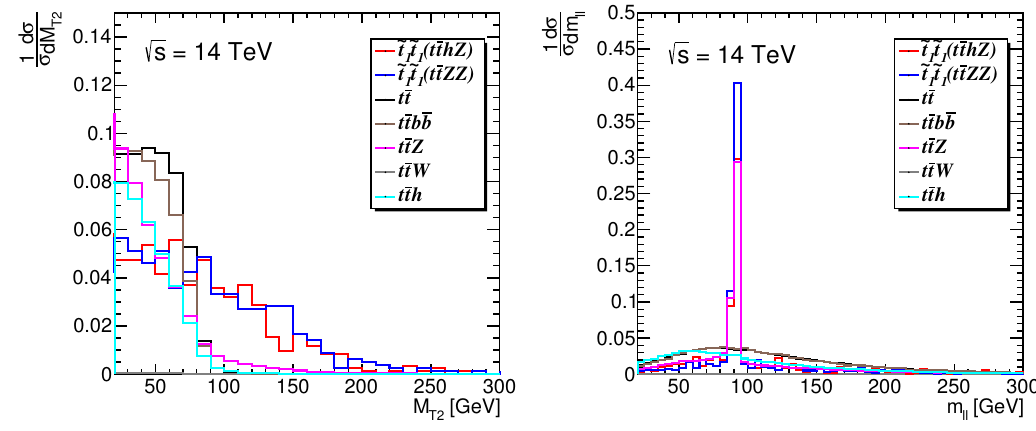
Figure 5 . Normalized distributions of M T 2 (left) and m ‘‘ (right) for the signal channels t (cid:22) thZ and t (cid:22) tZZ with m ~ = 620 GeV and the SM backgrounds after basic selection cuts. t 1